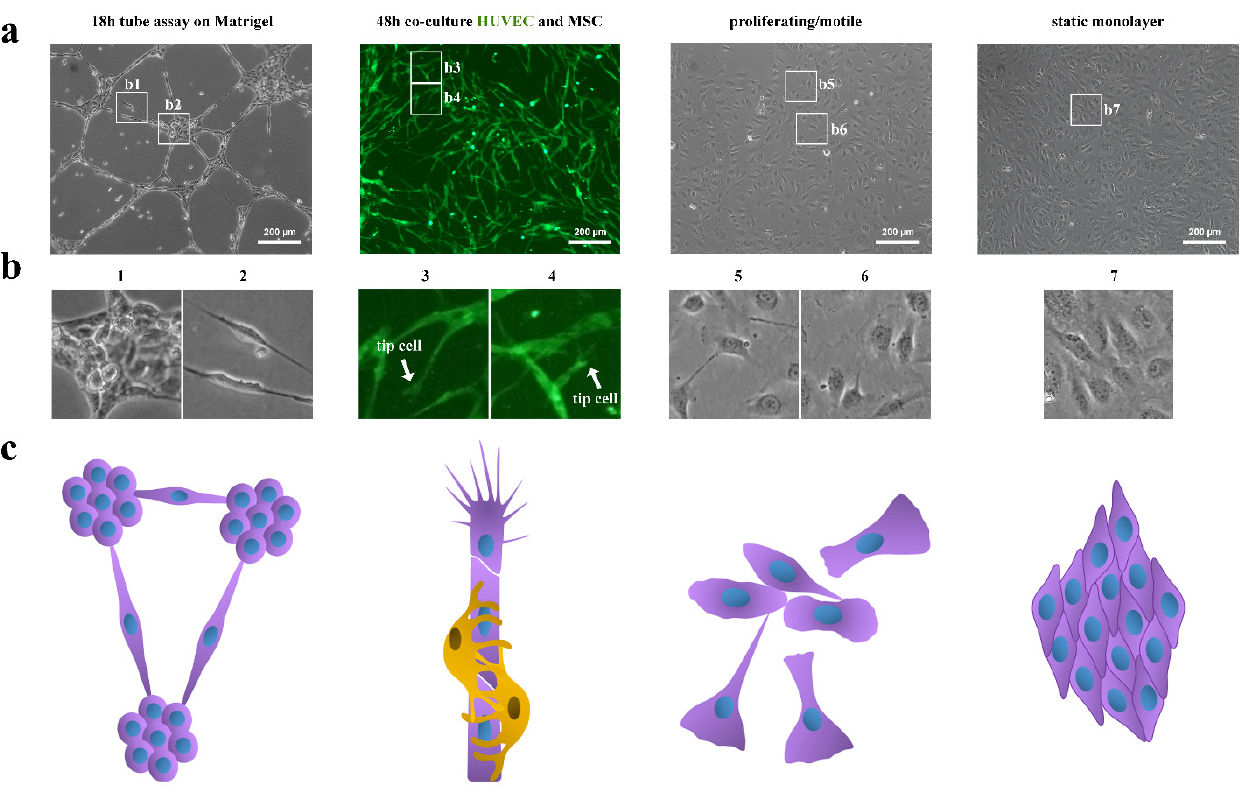
Figure 1. Representative images of ECs under different experimental settings. Tube assay on Matrigel TM (19 h). HUVECs were seeded on Matrigel TM at a density of 5 × 10 4 cells/cm 2 and cultured for 19 h in EGM-2 (Lonza). Co-culture model. HUVECs were preliminarily labeled with vital fluorescent dye CMFDA (green). The mixtures of HUVEC:MSC at a ratio of 1:3 and a density of 6 × 10 4 cells/cm 2 were seeded onto a Petri dish without matrix and co-cultured in EGM-2 (Lonza) for 48 h. Proliferating/motile culture of HUVECs: sparsely populated monoculture (3.6 × 10 4 cells/cm 2 ) in EGM-2 (Lonza) for 19 h. Static monolayer of densely populated HUVECs (7 × 10 4 cells/cm 2 ) for 19 h in EGM-2 (Lonza). Images were taken using the Axiovert 200 M Microscope (Zeiss, Oberkochen, Germany): 10 × amplification ( a ), 68 × amplification ( b ) of selected areas, where white arrows indicate tip cells among others. ( c ) A schematic representation of the formed cellular